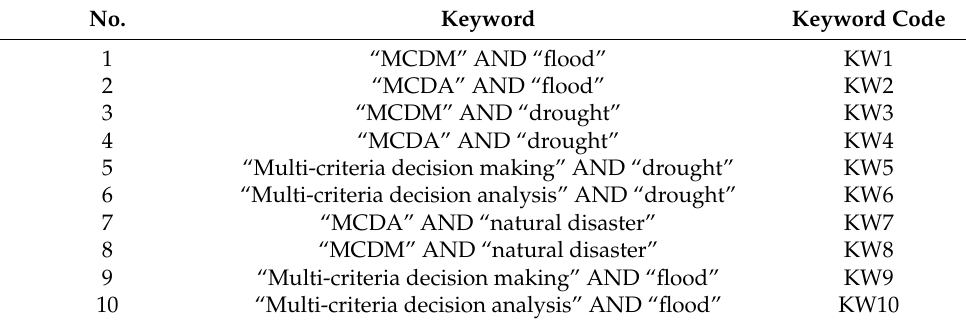
Table 4. Keywords and syntax used for online article